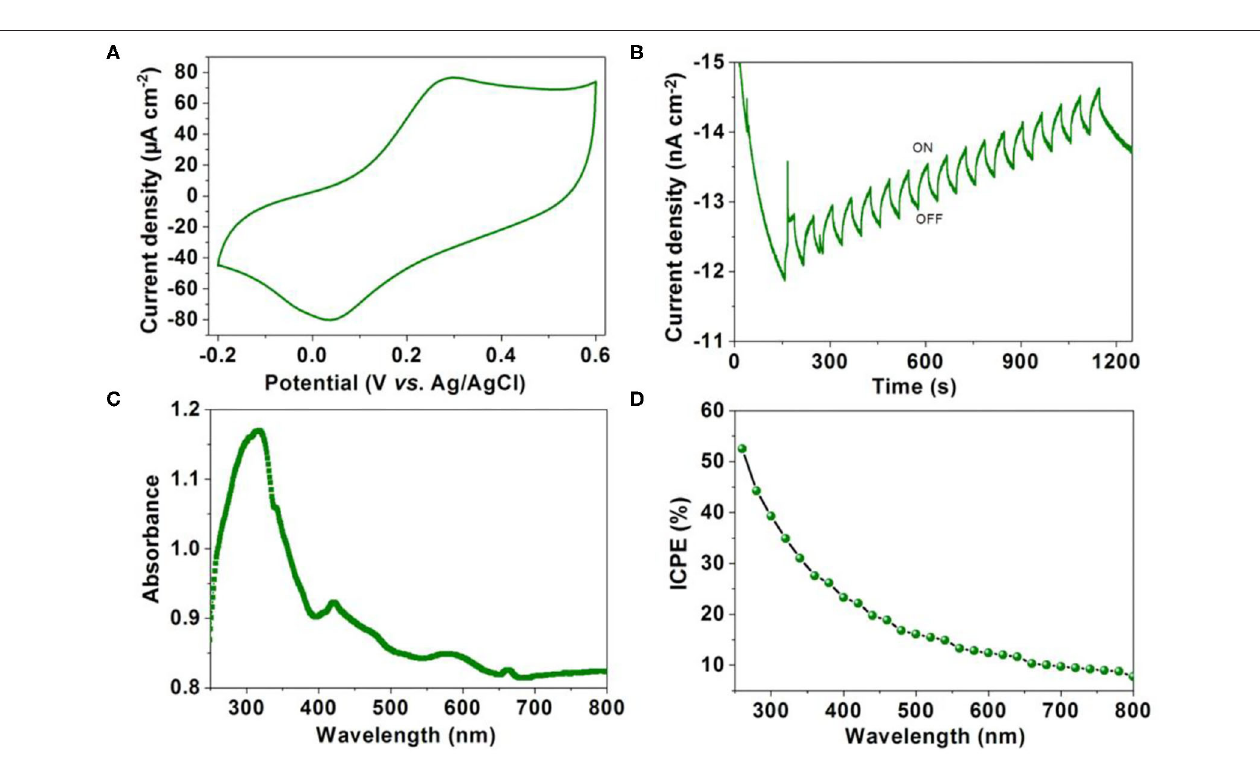
FIGURE 4 | View of the distributions of highest occupied molecular orbitals (HOMOs) and lowest unoccupied molecular orbitals (LUMOs) for 1 .